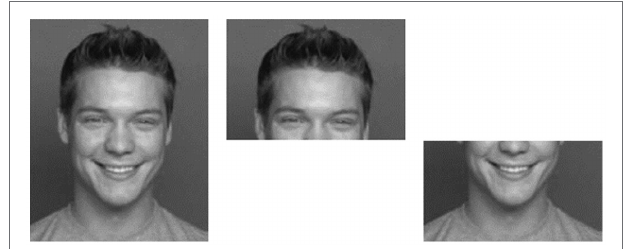
FIGURE 1 | Shown are examples for images used for the emotion-recognition task. Six different emotions were presented either as picture of the full face or as upper/lower halves. Pictures here are “full happy face” (top left), “upper half” (middle), and “lower half” (bottom right). Modified and reproduced with permission from (Max Planck Institute for Human Development, Center for Lifespan Psychology, Berlin, Germany), available at